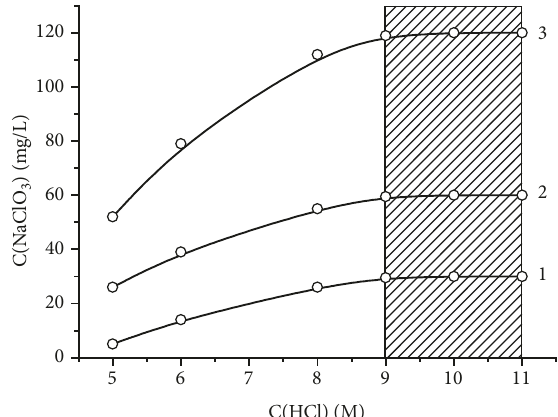
mixture after adding the sample and KI solution should be at least 5.5